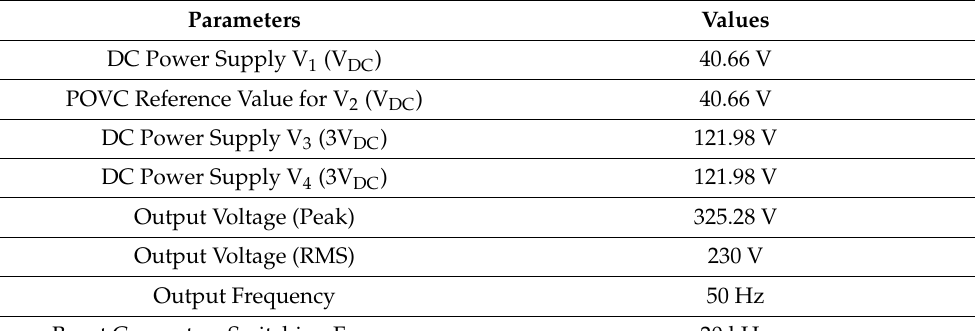
Table 6. Full system test parameters.